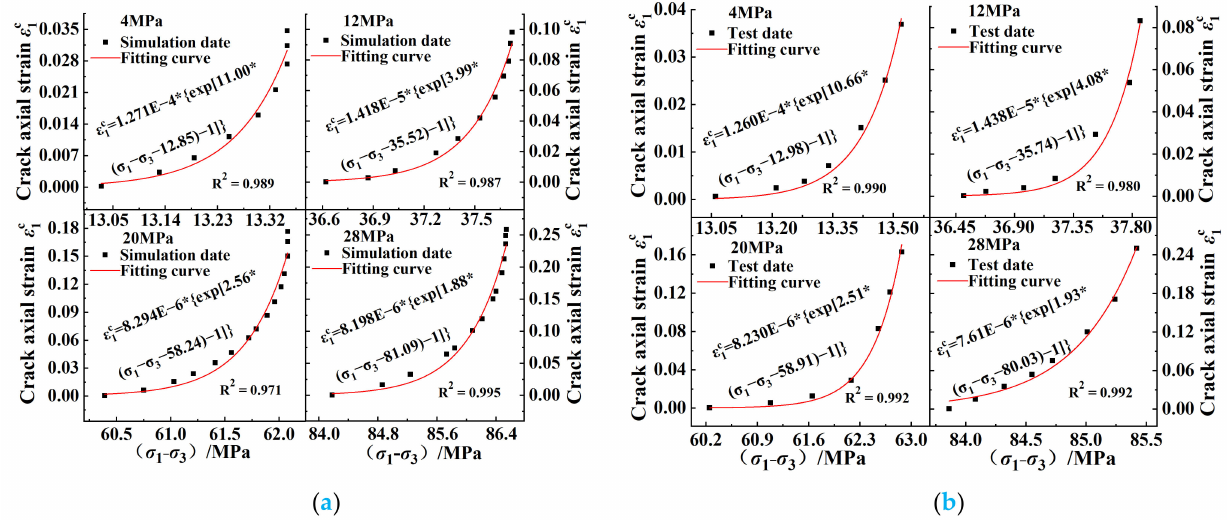
Figure 10. Verification of crack axial stress–strain − difference pre − peak curves under different confining pressures: ( a ) numerical simulation data validation; ( b ) laboratory data